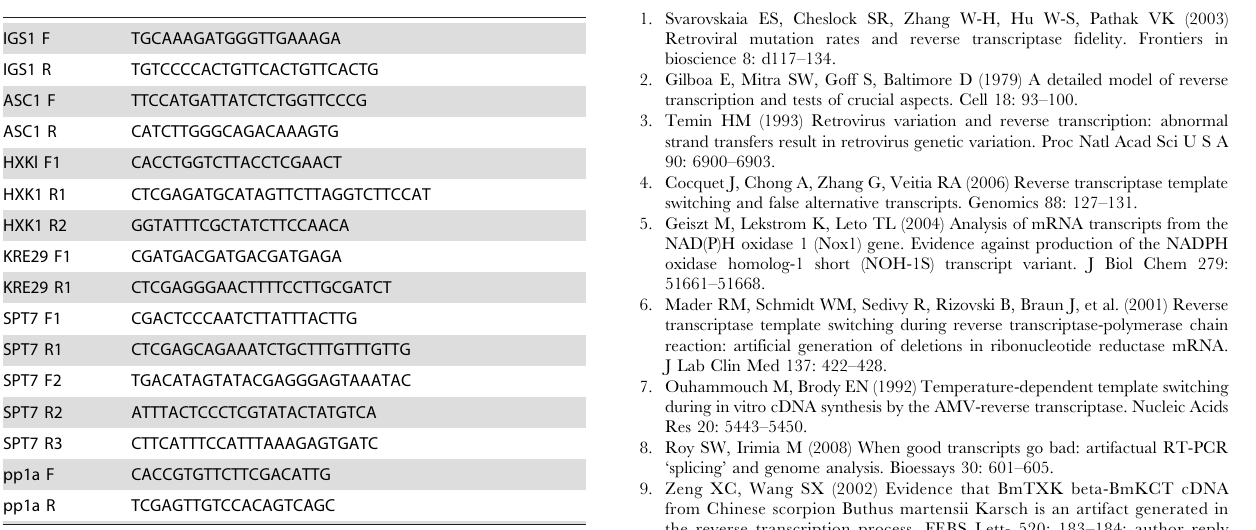
Table S1 Sequencing information. All sequences obtained in this project are shown. Regions of the sequence have been colour coded red, green and blue to indicate that they emanate from different molecules or different regions of the same molecule. Overlapping regions are shown in purple. Sequences were obtained either by direct sequencing of band-purified PCR products, or for complex PCR products by sequencing multiple clones ligated in pGEM-T.